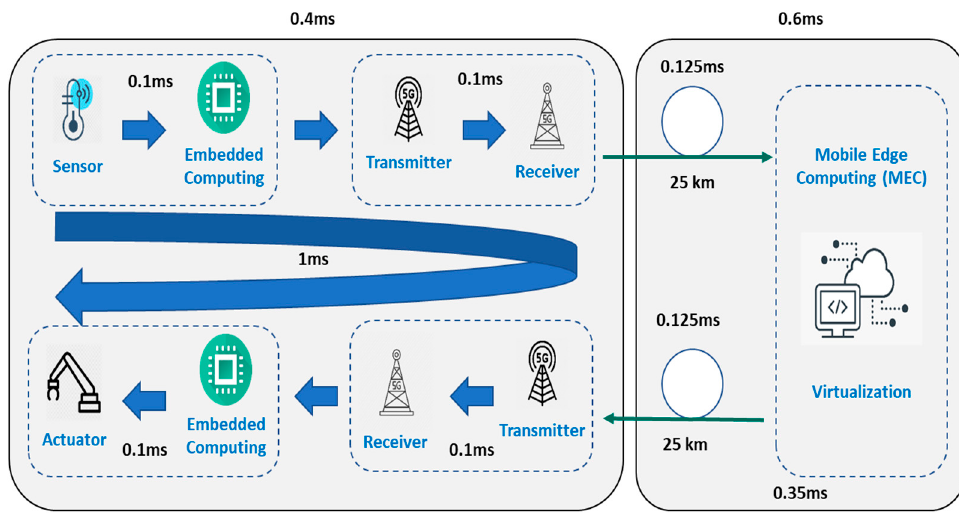
Figure 9. The various latency components of a typical ΤΙ system [41].